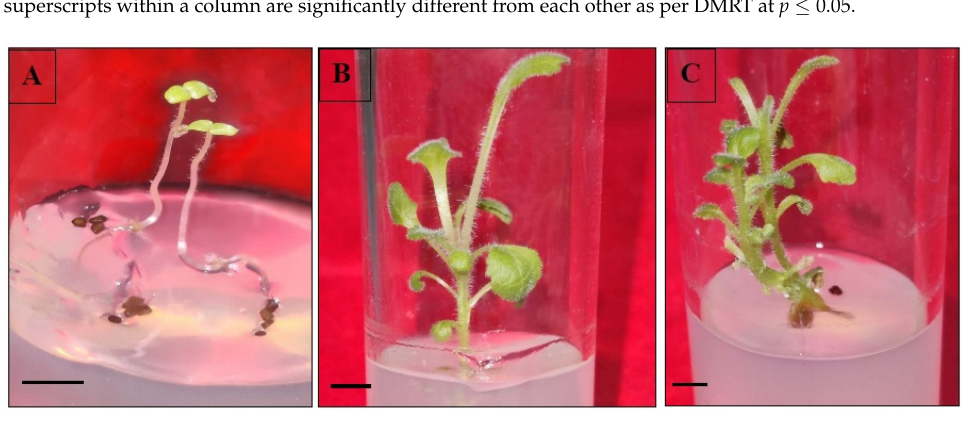
Figure 1. In vitro germination of seeds and direct shoot regeneration in D. purpurea . ( A ) Germinated seedlings having elongated hypocotyls (bar = 0.5 cm). ( B , C ) In vitro direct shoot proliferation (bars = 1.0 cm).